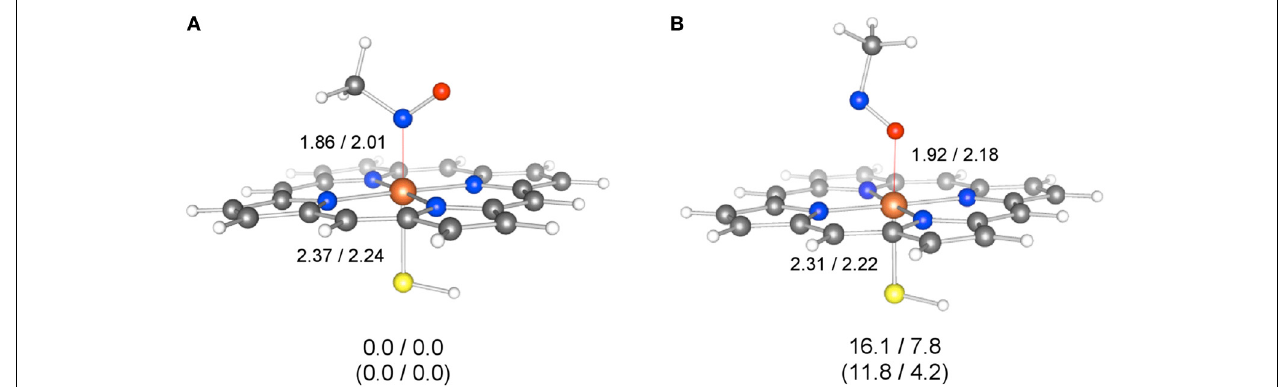
FIGURE 7 | Geometries of N-bound (A) and O-bound (B) forms of 1 MIC(II) and 2 MIC(III), optimized at the M06/[SDD(Fe),6-31G ∗ (other)] level. Key distancesaregiveninÅ.Thevaluesbelowthegeometriesarerelativeenergies